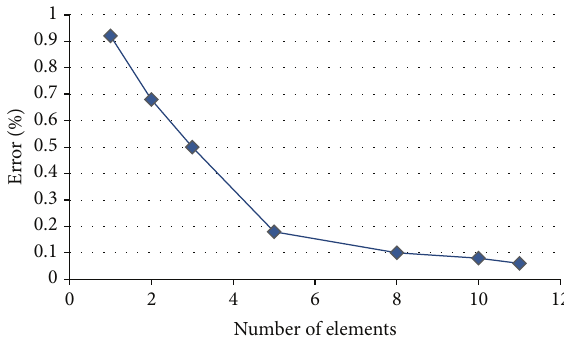
Figure 3: DFE convergence analysis for cantilevered beam; 𝑃 = = 0 (5th natural frequency). 1.23 MN, 𝑀 𝑧𝑧